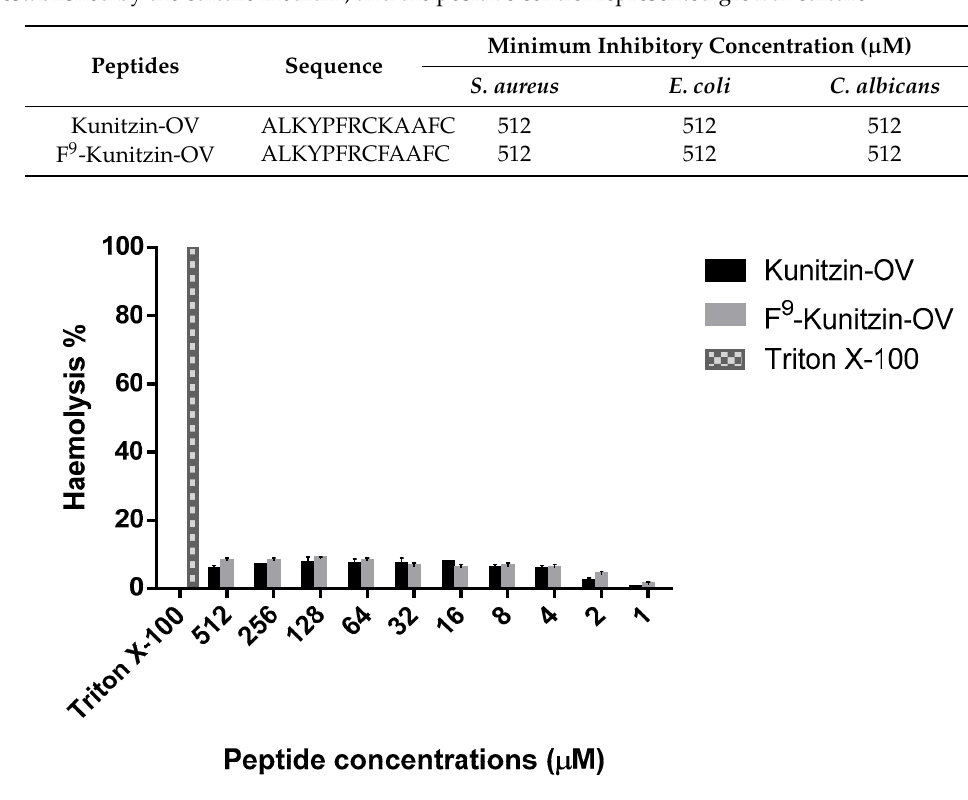
Table 2. Minimum inhibitory concentrations (MICs) determined for the Gram-positive bacterium, Staphylococcus aureus (S. aureus) , the Gram-negative bacterium, Escherichia coli (E. coli) , and the yeast,